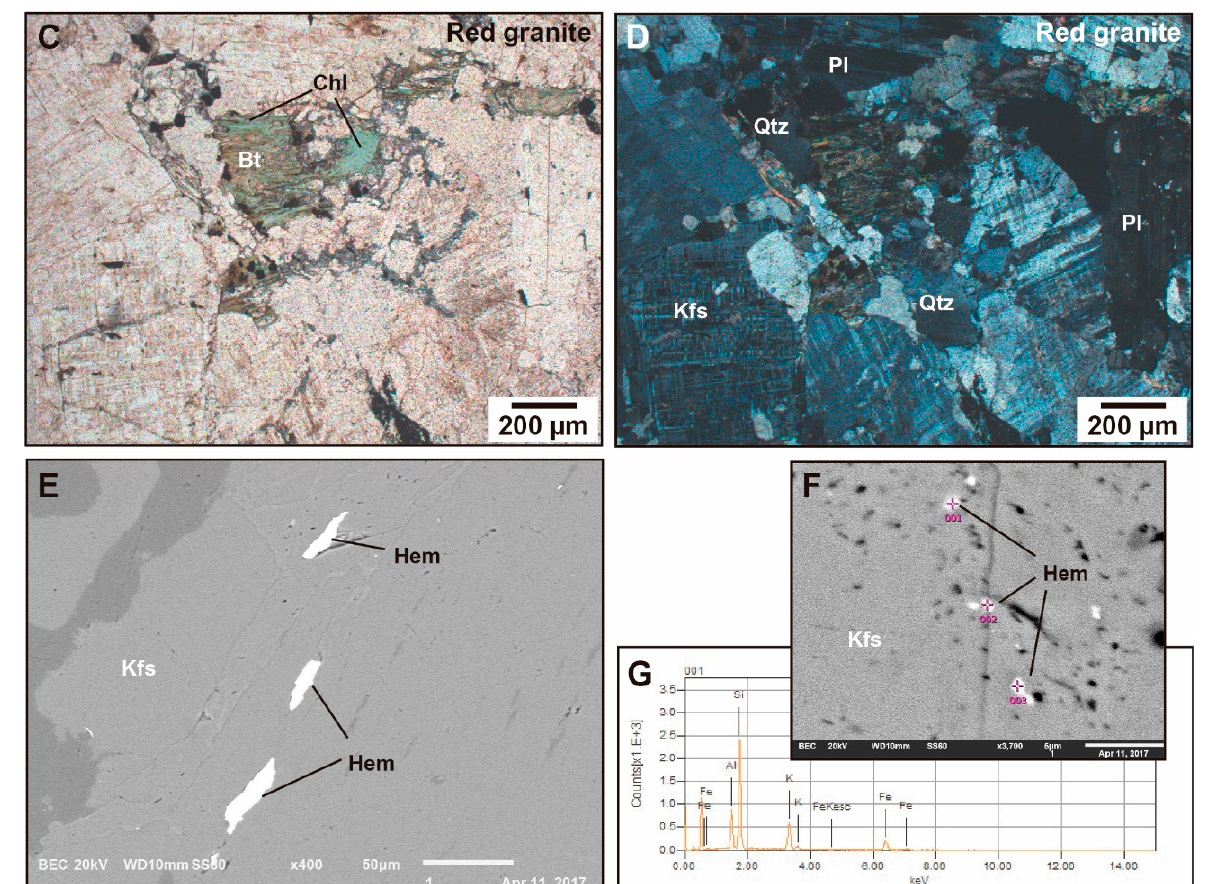
Figure 2. Red granite textures: ( A , B ) Red granite with medium-grained isotropic texture; biotite crystals altered to chlorite; photographs come from underground mine ( A ) and from borehole ( B ); ( C , D ) Photomicrographs in natural ( C ) and polarized ( D ) light of the red granite with biotite altered to chlorite, in a medium-grained isotropic texture (thin section of sample from underground mine); ( E ) scanning electron microscopy (SEM)/back-scattered electron (BSE) image showing elongated hematite crystals in planes parallel to the K-feldspar cleavage; ( F ) Hematite crystals in pores of K-feldspar with location of energy-dispersive spectroscopy (EDS) analyses (SEM-BSE image); ( G ) EDS spectrum indicating the presence of Fe in the inclusions analysed. Abbreviations: Bt—biotite; Chl—